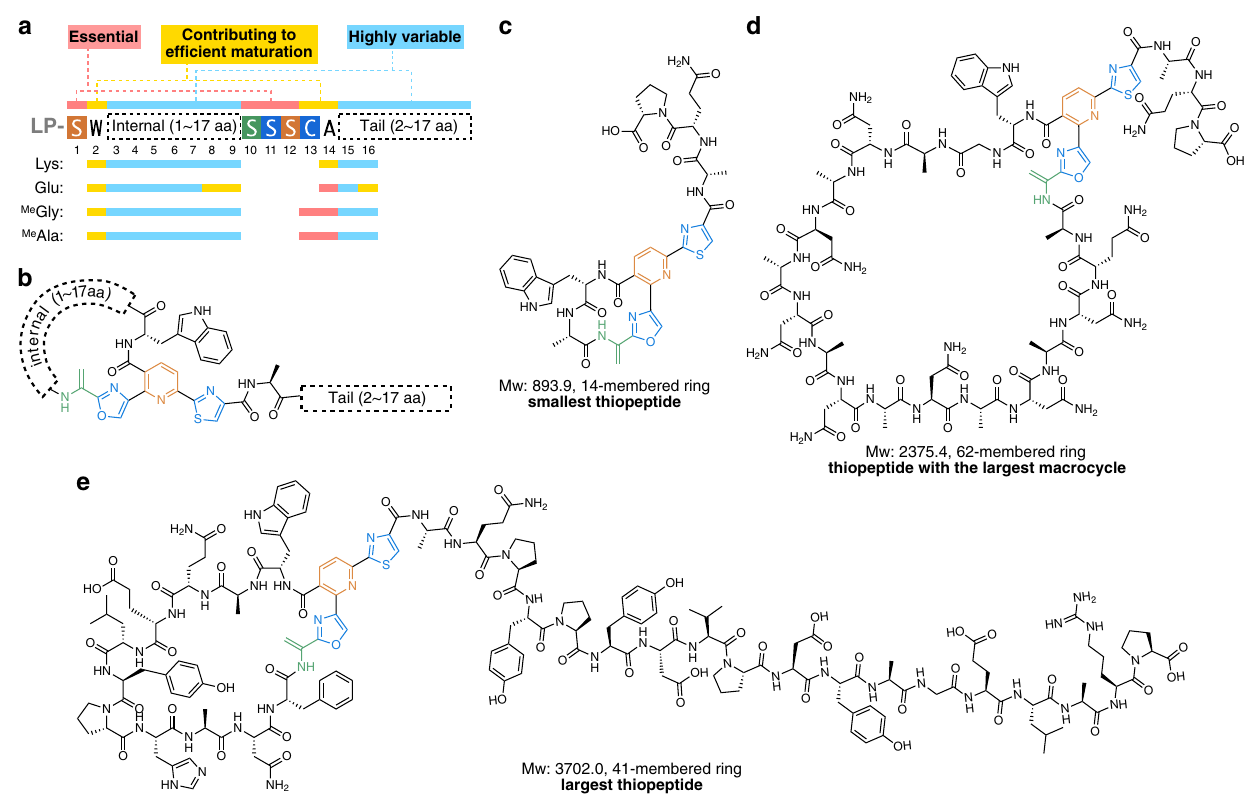
Fig. 6 Summary of the work. a Primary sequence representation of the minimal lactazole scaffold with the outcomes of the Lys, Glu, Me Gly, and Me Ala- scanning experiments mapped to the resulting consensus sequence. b Chemical structure representation of the minimal lactazole scaffold. c – e Structural diversity of thiopeptides accessible with the FIT-Laz system. Displayed are chemical structures of the smallest arti fi cial lactazole c , thiopeptide with the largest macrocycle d , and the largest construct e synthesized in this